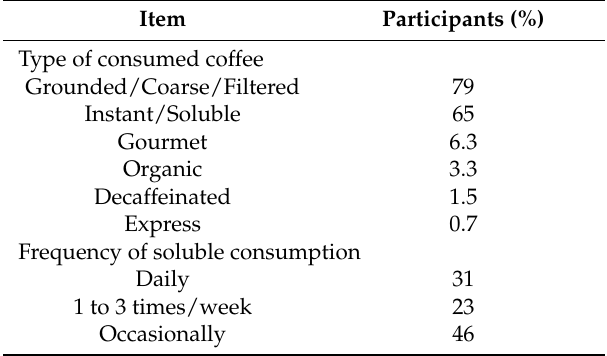
Table 4. Participants coffee consumption profile ( n =